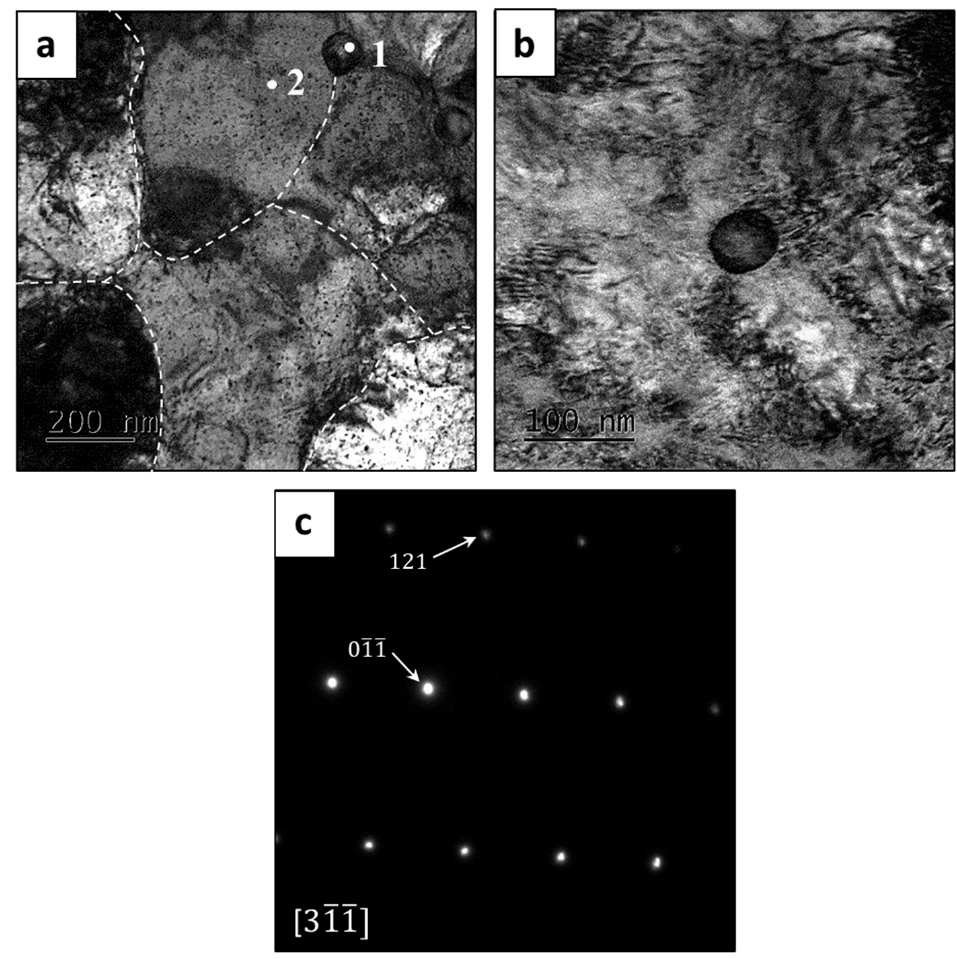
Figure 7. TEM analysis of HEA WTaMoNbV produced by LPBF process: ( a , b ) bright field (BF), ( c ) electron diffraction image of the alloy matrix. Table 8. Local chemical compositions (at. %) by EDS analysis, related to Figure 6a.